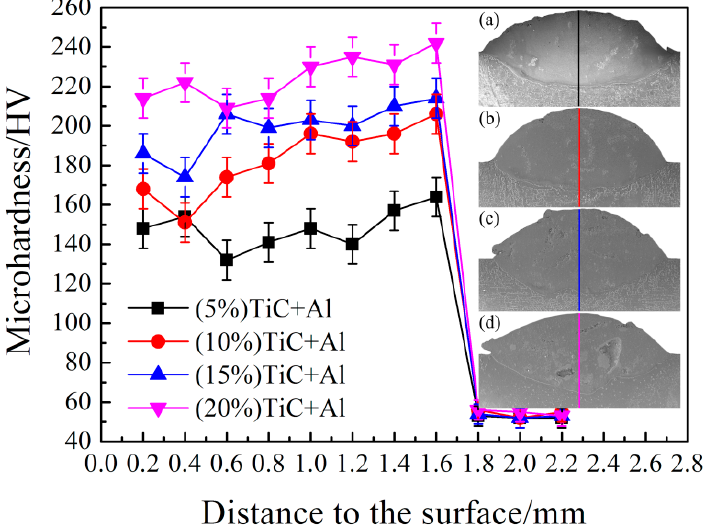
Figure 5. Microhardness distribution of the composite coating: ( a ) Al+5wt%TiC; ( b ) Al+10wt%TiC; ( c ) Al+15wt%TiC; ( d ) Al+20wt%TiC.